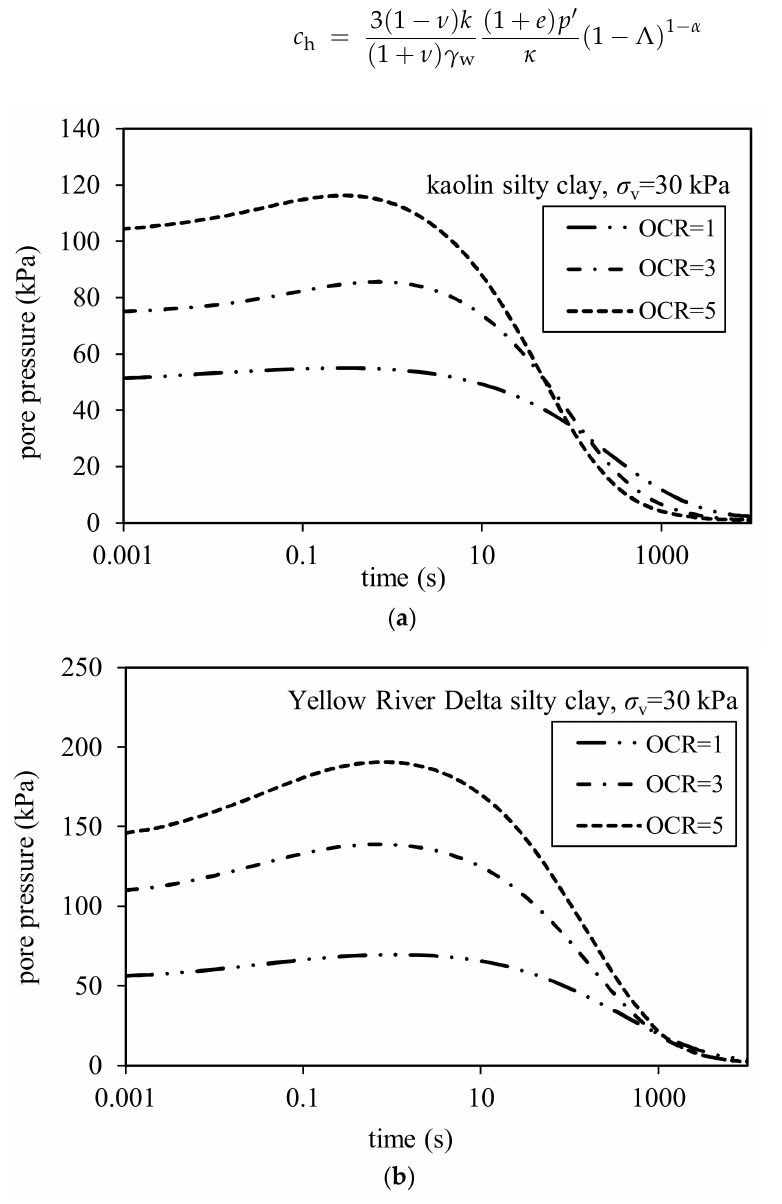
Figure 8. Pore pressure dissipation curve under different OCR at σ v = 30 kPa. ( a ) Kaolin silty clay; ( b ) Yellow River Delta silty